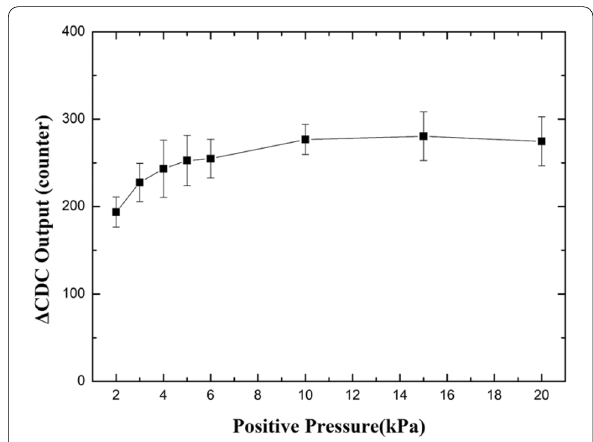
Fig. 5 Change of difference in CDC signal of membrane sensor according to positive pressure (n